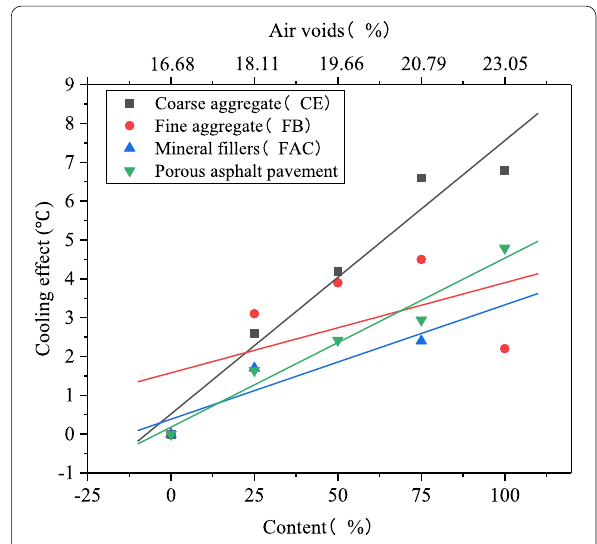
Fig. 4 Cooling effect of different thermal resistant pavements